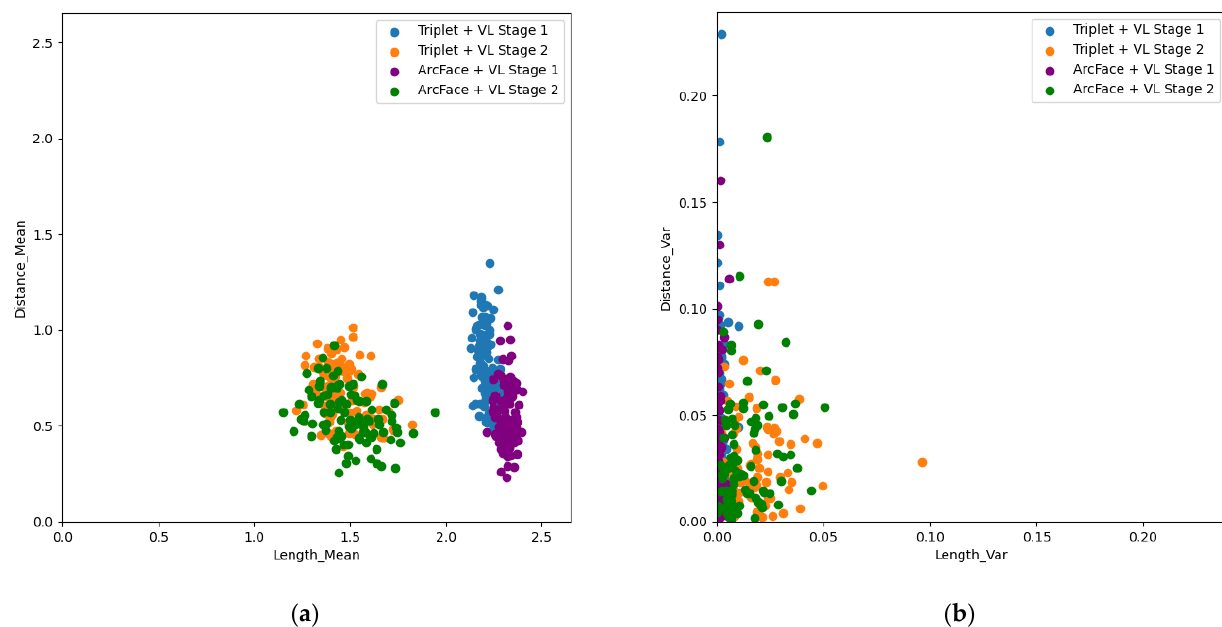
Figure 9. Mean and variance of D and L of models trained with the proposed learning method. ( a ) mean; ( b ) variance.